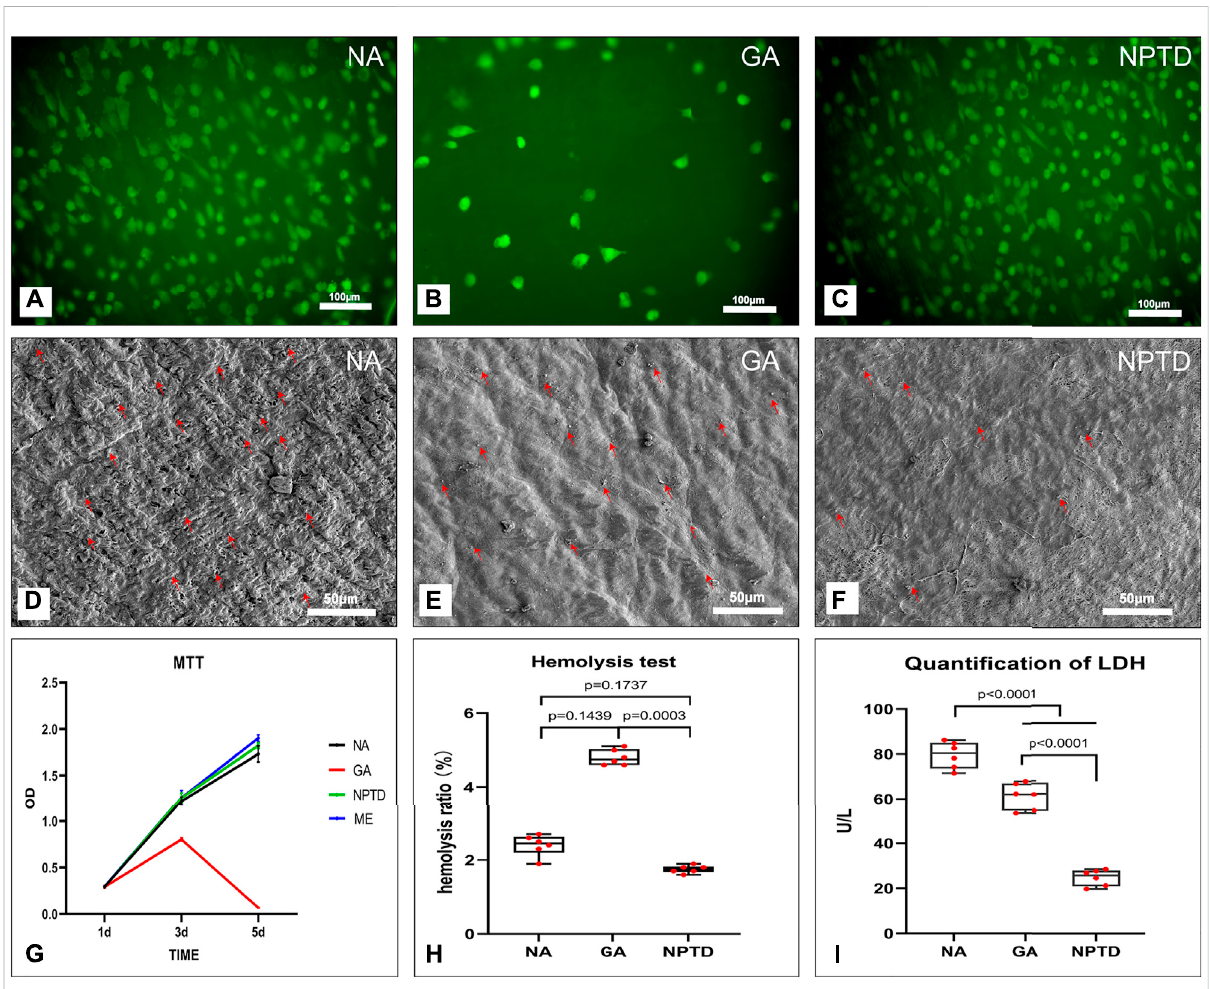
FIGURE 5 ThecytocompatibilityandHemocompatibilityofthebovinepericardium.Thehumanumbilicalveinendothelialcells(HUVECs)proliferationand morphology was assessed by 6-CDCFDA live cell fl uorescent staining (A,B,C) , the HUVECs almost completely covered the surface of the NA and NPTDgroupsonday5whileonlyafewcellsintheGAgroup (A,B,C) .Thecytotoxicityofthelea fl etswasdeterminedbyMTTassay,therelativegrowth ratios of GA group was signi fi cantly lower than that of the NA and NPTD groups (G) . The platelet adhesion on the surface of the samples was evaluated by SEM imaging (D,E,F) and LDH assay (I) . Red arrows indicate adherent platelets. The quanti fi cation of LDH in the NPTD group was signi fi cantly lower than that of the NA and GA groups. The hemolysis ratio of LDH in the NPTD and NA group was signi fi cantly lower than that of the GA group (H) . Statistical analysis was performed by one-way analysis of variance